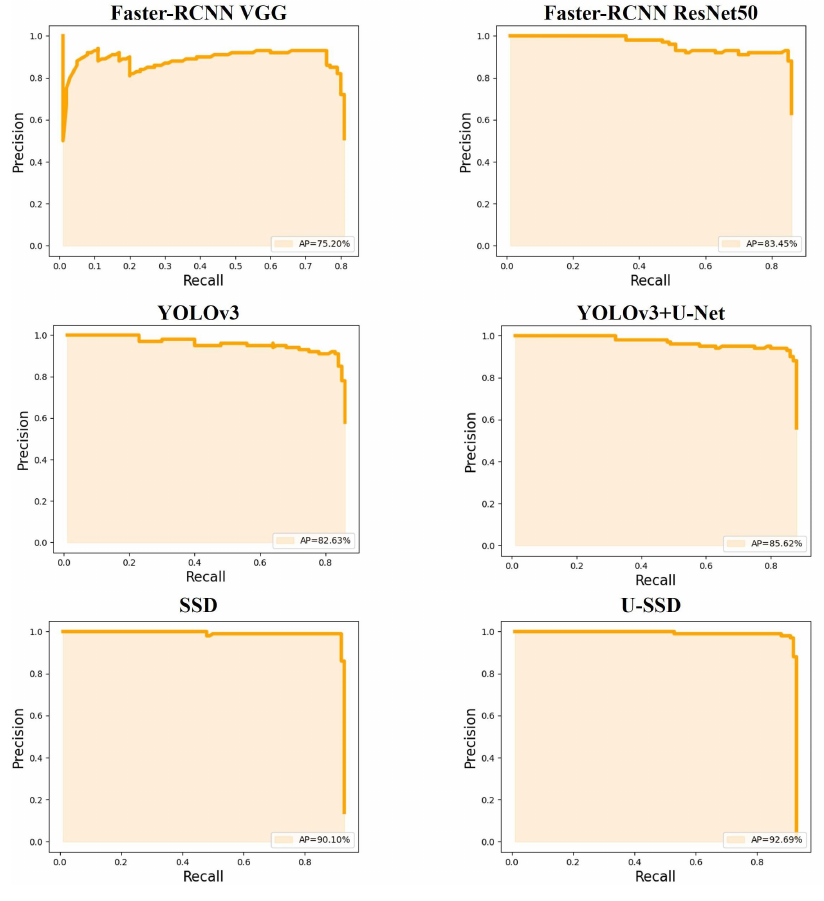
Figure 7. P-R curve at IoU = 0.8 on our dataset.